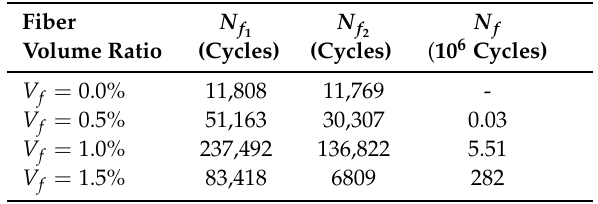
Figure 9. Comparison of the experimental data of Goel and Singh [44] with the fitted probabilistic model Equation (8) for concrete reinforced with steel fibers, ( a ) 0%; ( b ) 0.5%; ( c ) 1.0% and ( d ) 1.5% volume ratios. Table 8. Comparison of the mean fatigue life cycles given by Goel and Singh, 2014 [44], N f , and those 1 predicted by inverting Equation (8), N f , for the tests in [44] at a stress level of 80%. N f is the predicted 2 mean fatigue life when σ max is set at the static strength of the plain concrete (4.85